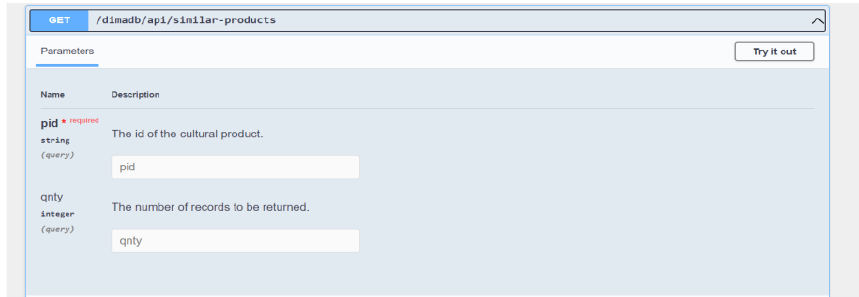
Fig. 8. Similar products recommender API.